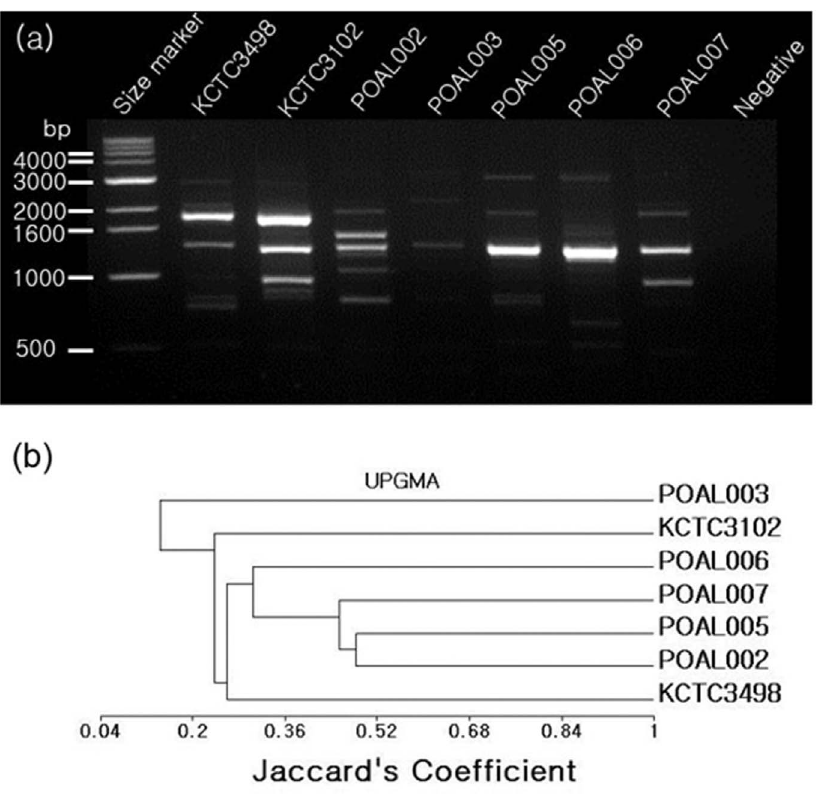
Figure 1. Phylogenetic analysis of isolated L.brevis strains by RAPD. (a) A representative RAPD analysis with primer OPA-08 (b) UPGMA phylogenetic tree of isolated strains.